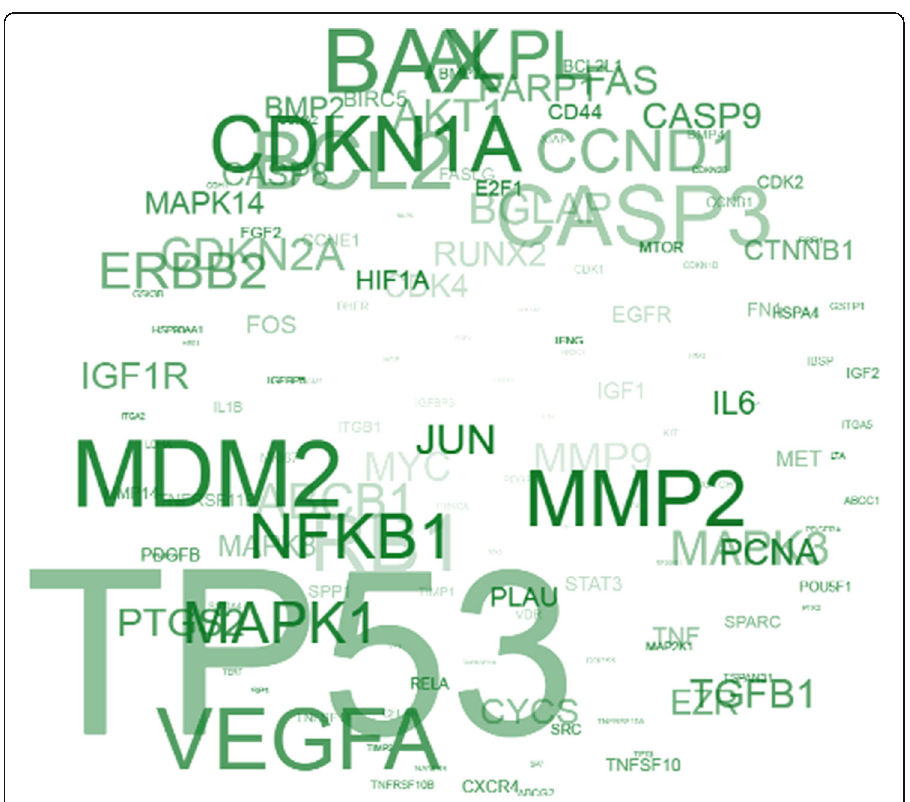
Fig. 4 TP53 is one of the top dysregulated genes in osteosarcoma (OS) patients according to the previous study (doi: